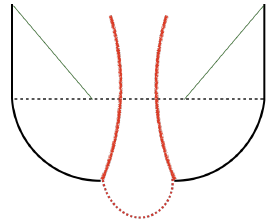
Figure 3. The naive bulk dual of | ψ i , given by analytically continuing the naive saddle-point of the norm path integral (as described in section 1). Again, solid black lines represent the AdS boundary, solid red lines the ETW branes and the green line is the black hole